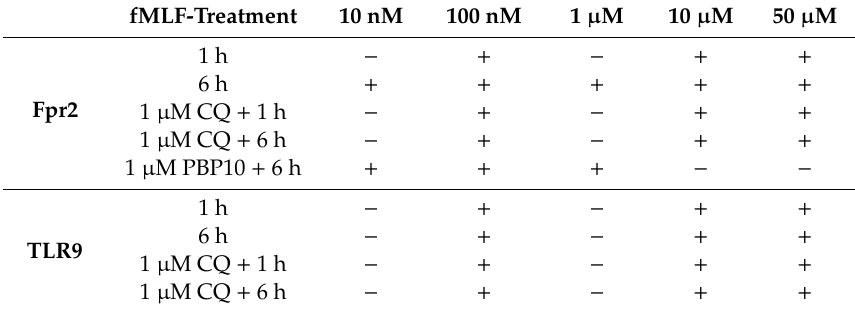
Table 1. The treatment schedule to study the formylated peptide-mediated stimulation of Fpr2 and TLR9 in RT4 cells induced using various concentrations of fMLF and pretreated with inhibitors.